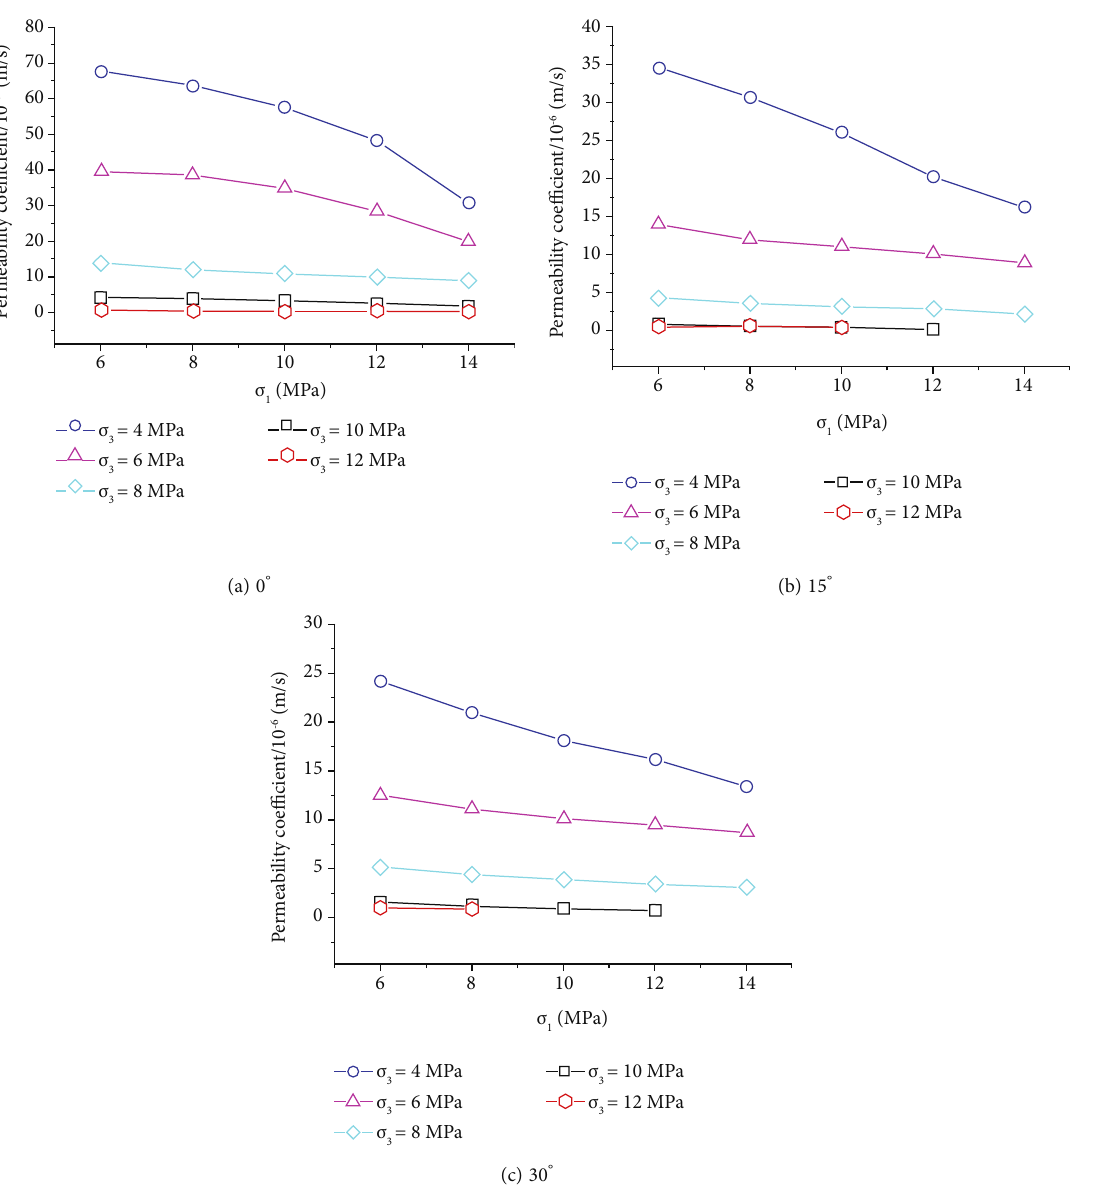
Figure 17: Hydraulic conductivity under three-dimensional